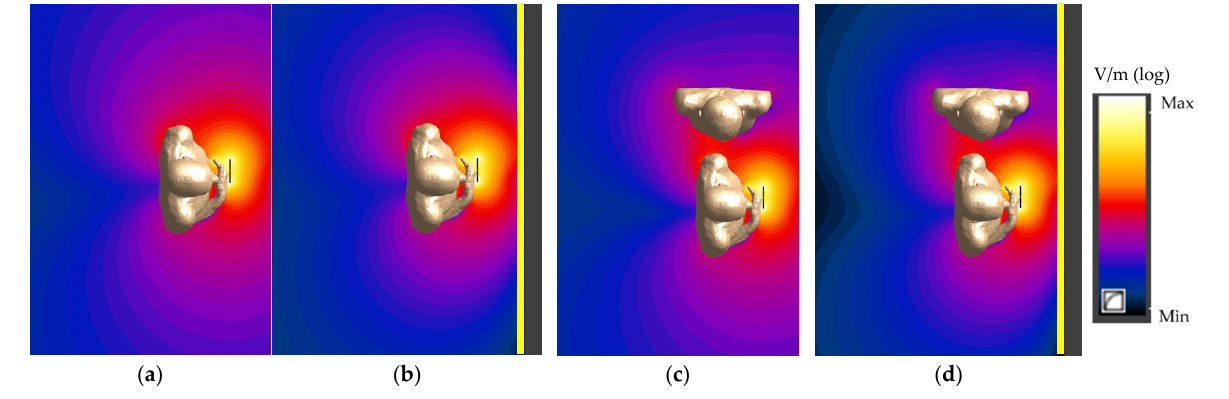
Figure 6. The normalised electric field distribution in a horizontal plane perpendicular to the centre of the HF RFID reader plane in various exposure scenarios: ( a , b ) the person using PICC device; ( c , d ) the person using PICC device and a bystander (reader on a vertical column ( a , c ) or attached to the vehicle cabin ( b , d ); logarithmic scale). Table 1. Magnetic field strength values in various exposure scenarios near to the HF RFID reader with an internal antenna of inner dimensions of 8 × 8 cm, operating with an output power sufficient for an RR of 10 cm (according to ISO/IEC 14443-2:2020 requirements for PICCs of classes 1–3).